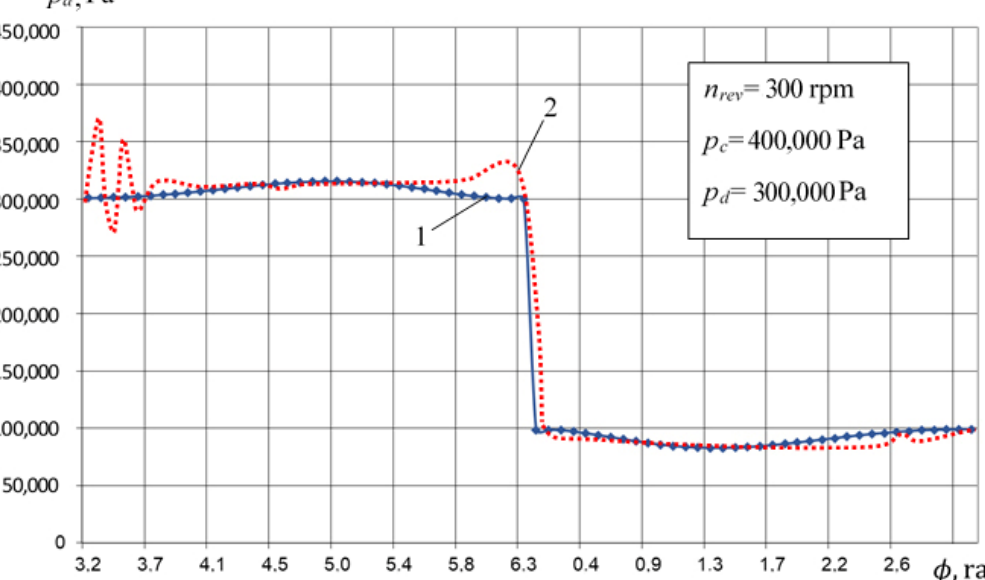
Figure 13. Dependence of the instantaneous pressure in the pump section in a crosshead-free PHPM determined experi- mentally and by calculation (1—Calculation; 2—Experiment).